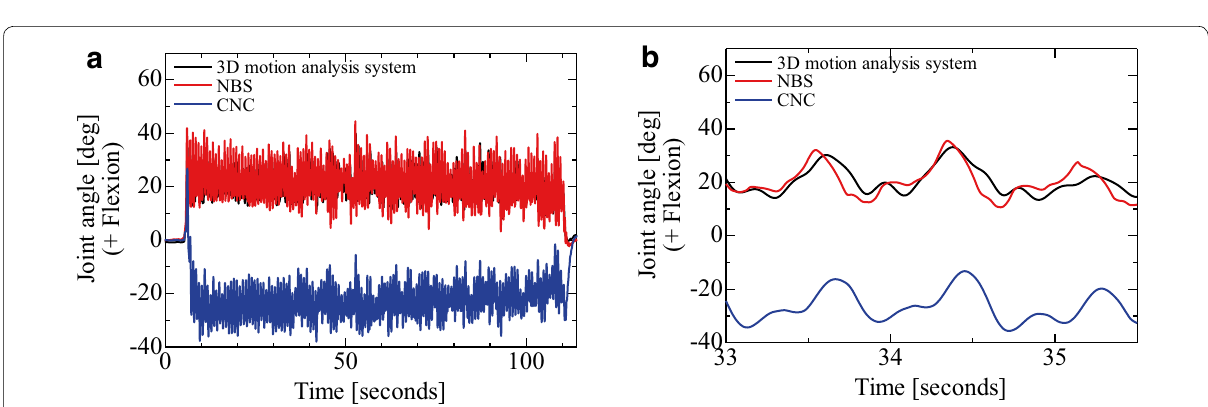
Fig. 6 Results of hip joint angles (Subject A). a The results over the entire measurement time. b The results between 33 and 35.5